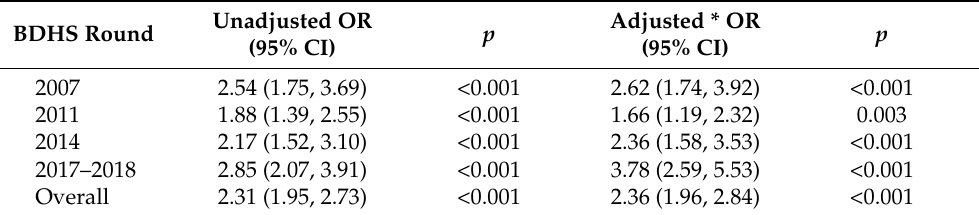
Table 3. Survey round-specific association between the adolescent mother’s stunting and the child’s stunting status.